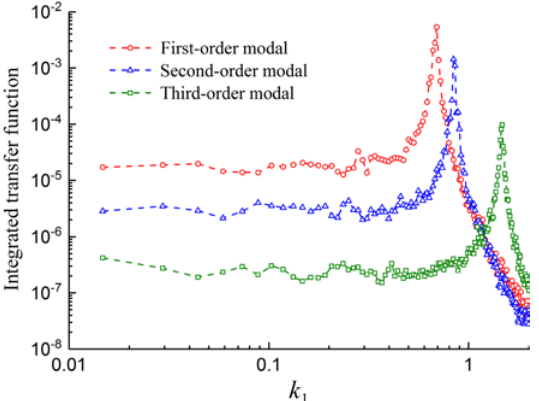
Figure 17. Integrated transfer function identification results.